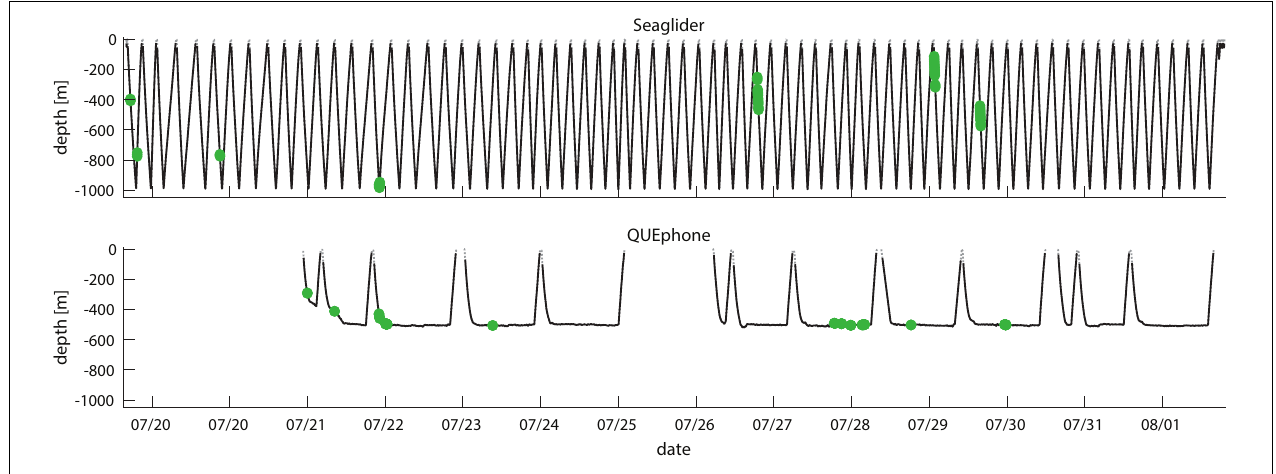
FIGURE 4 | Dive profile of Seaglider (top panel) and QUEphone (bottom panel) showing platform depth over time. Minutes with Cuvier’s beaked whales clicks present are shown by green dots. Date ticks are at 00:00 UTC.